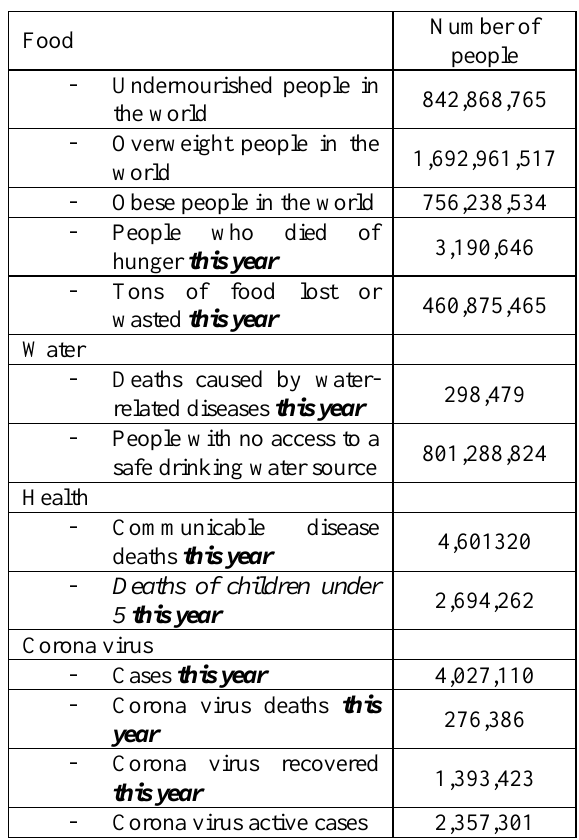
Table 1. Selected world crisis